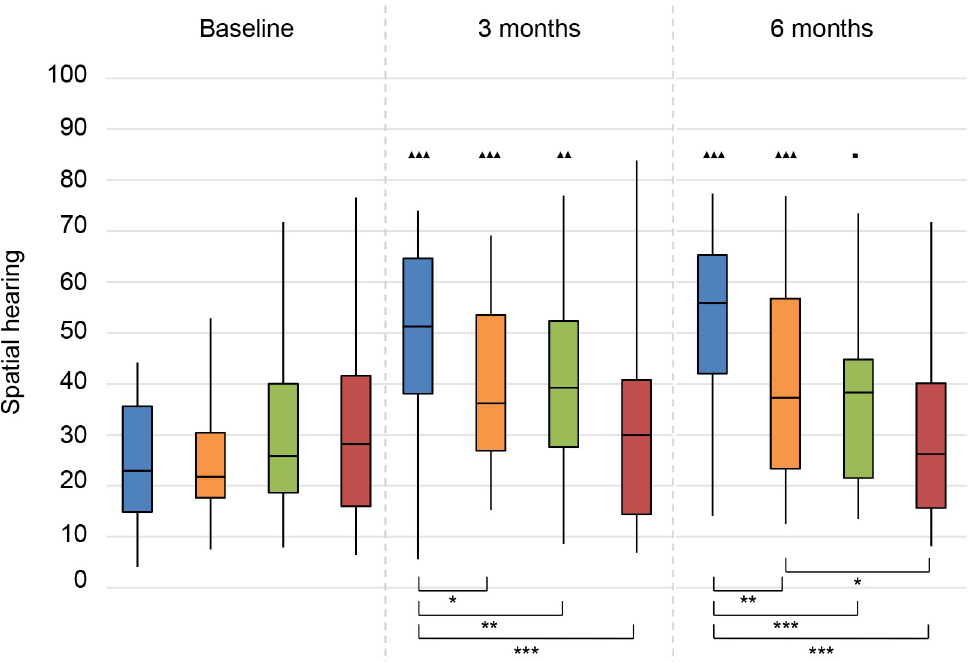
Fig 11. Speech, Spatial and Qualities of hearing questionnaire (SSQ). Spatial hearing subscale. Statistical difference compared to baseline. ▲▲▲ = p < 0.001; ▲▲ = p < 0.01; ▲ = p < 0.05. Statistical difference compared to 3 months follow-up. ■■■ = p < 0.001; ■■ = p < 0.01; ■ = p < 0.05. Statistical difference between groups at same follow-up moment. ��� = p < 0.001; �� = p < 0.01; � = p < 0.05.